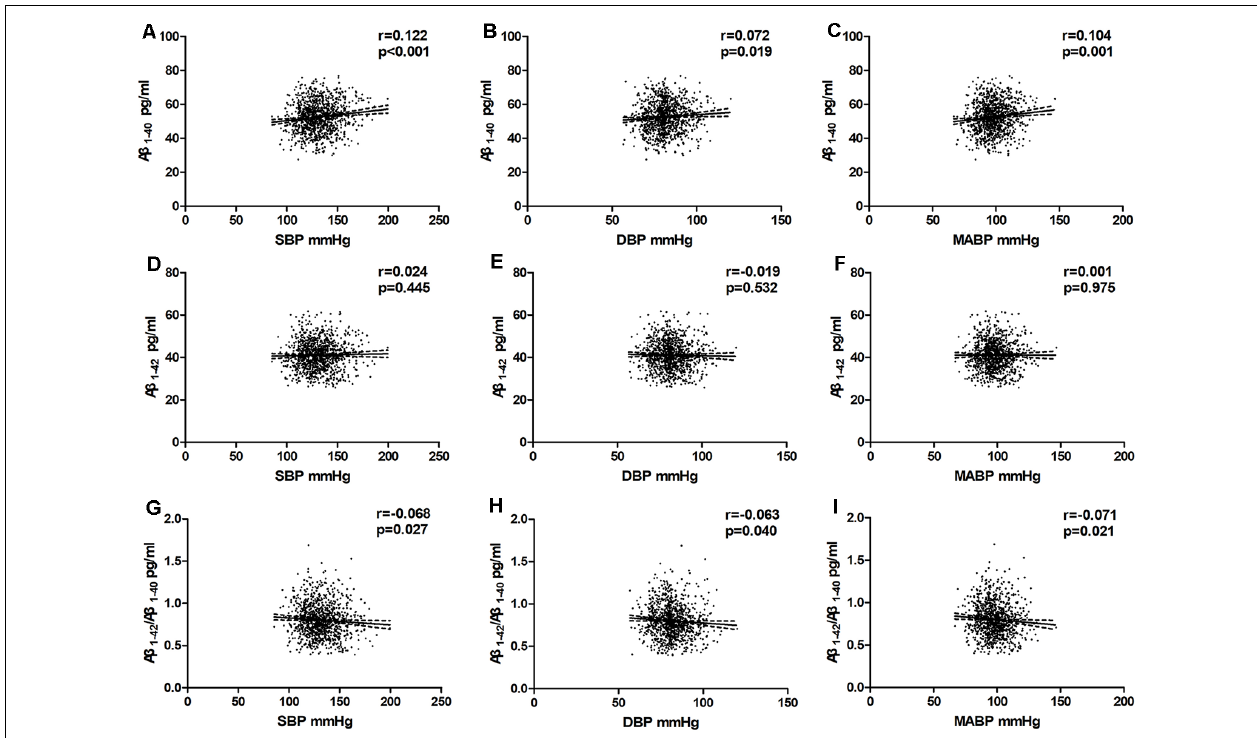
FIGURE 3 | Partial linear correlations between plasma A β and SBP, DBP, MABP in total participants. Partial linear correlations of blood pressure (BP) with plasma A β 1–40 levels (A–C) and plasma A β 1–42 levels (D–F) and A β 1–42 /A β 1–40 (G–I) are shown in the figure. Partial correlation coefficients and P values were obtained after adjustment for age, sex, BMI, pulse rate, log-transformed fasting blood glucose, log-transformed TG, TC, HDL-C, smoking, drinking, physical activity level, stroke, transient ischaemic attack (TIA), and heart disease.